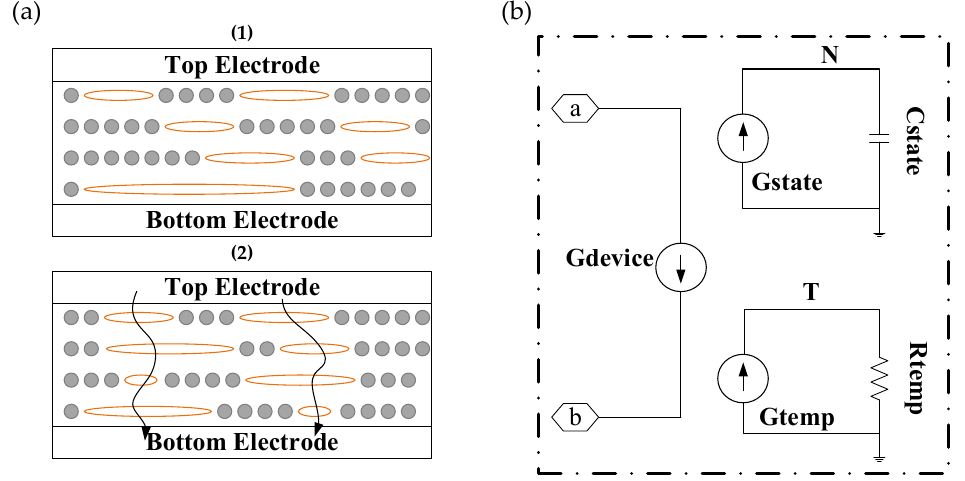
Figure 9. ( a ) Illustration of transport mechanism in GO-RRAM based on hybridization state modulation; ( b ) SPICE macro implementation of the compact hybridization state modulation model.